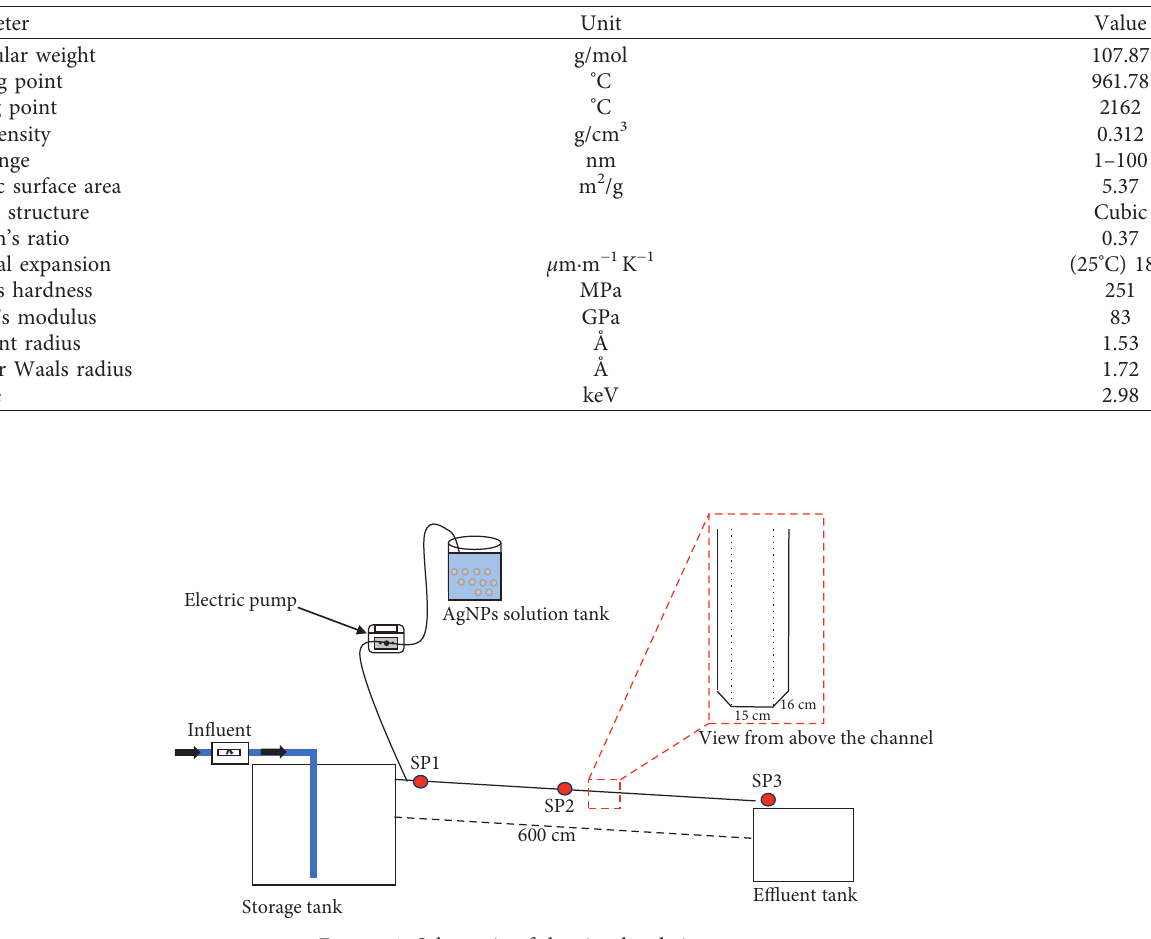
Table 1: Physiochemical properties of AgNPs [16].